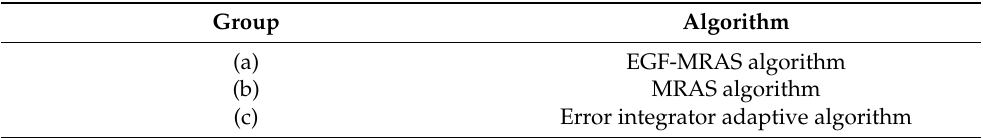
Table 3. Simulation groups of algorithms.